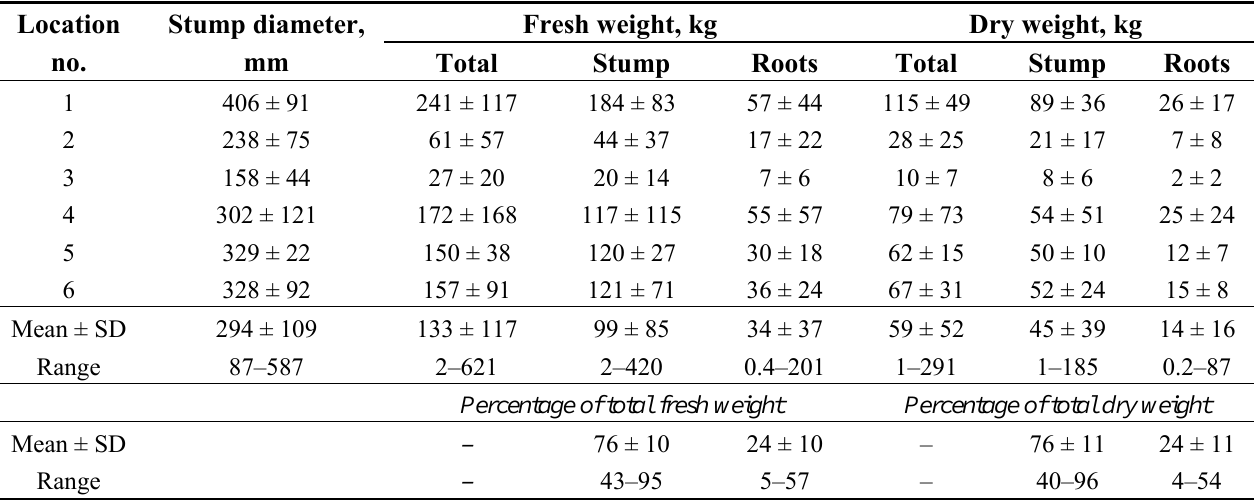
Table 3. Fresh and dry mass production (kg) and mean percentage of total stump and root